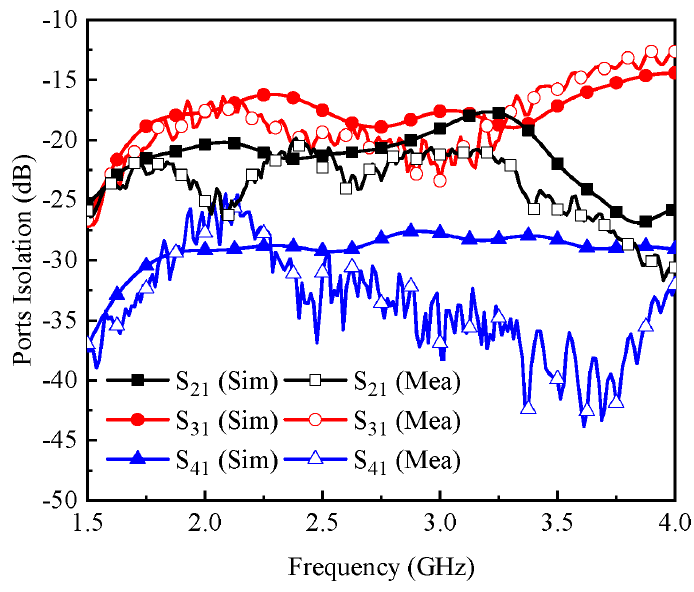
Figure 6. Simulated and measured isolation between the MIMO antenna elements.